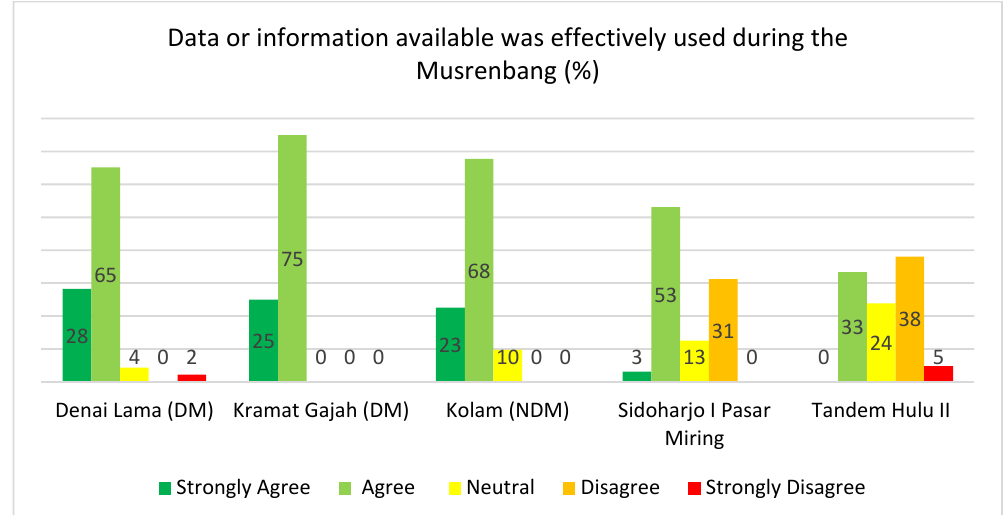
Figure 7. The effective use of available data during the Musrenbang.